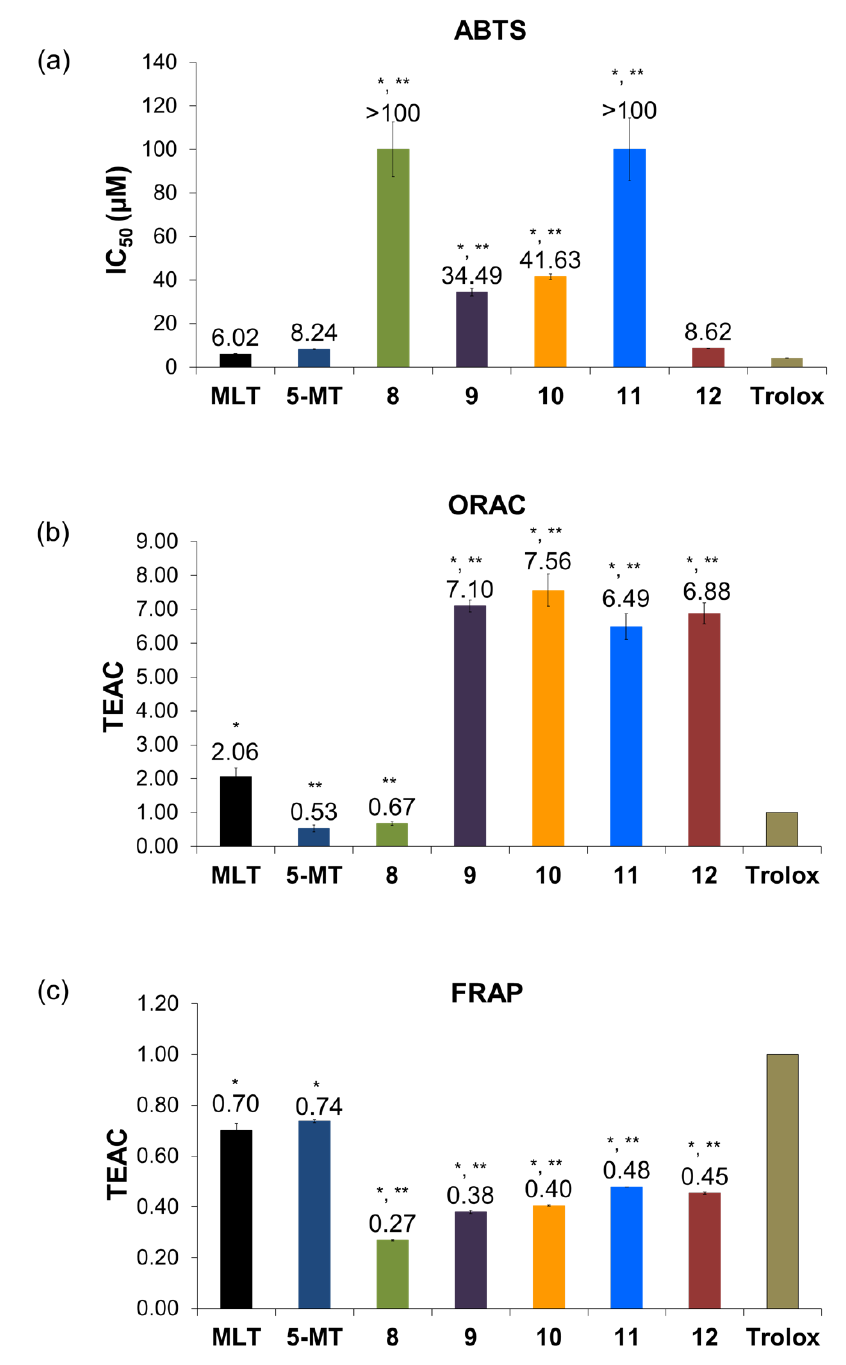
Figure 4. The antioxidant capacities of MLT and its derivatives on ( a ) ABTS, ( b ) ORAC, and ( c ) FRAP assays. Data represented mean ± SD (n = 3). * p < 0.05 compared with trolox, ** p < 0.05 compared with MLT.